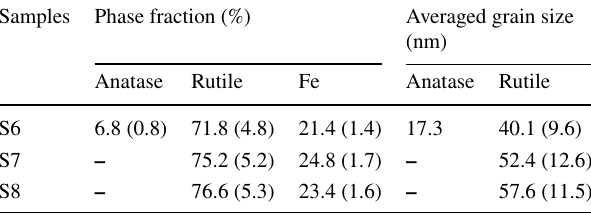
Table 1 Phase fraction and averaged grain size of S6, S7, and S8 Samples Phase fraction